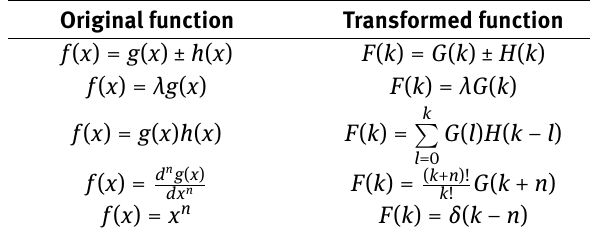
Table 1: Basic operations of DTM for the governing equations Original